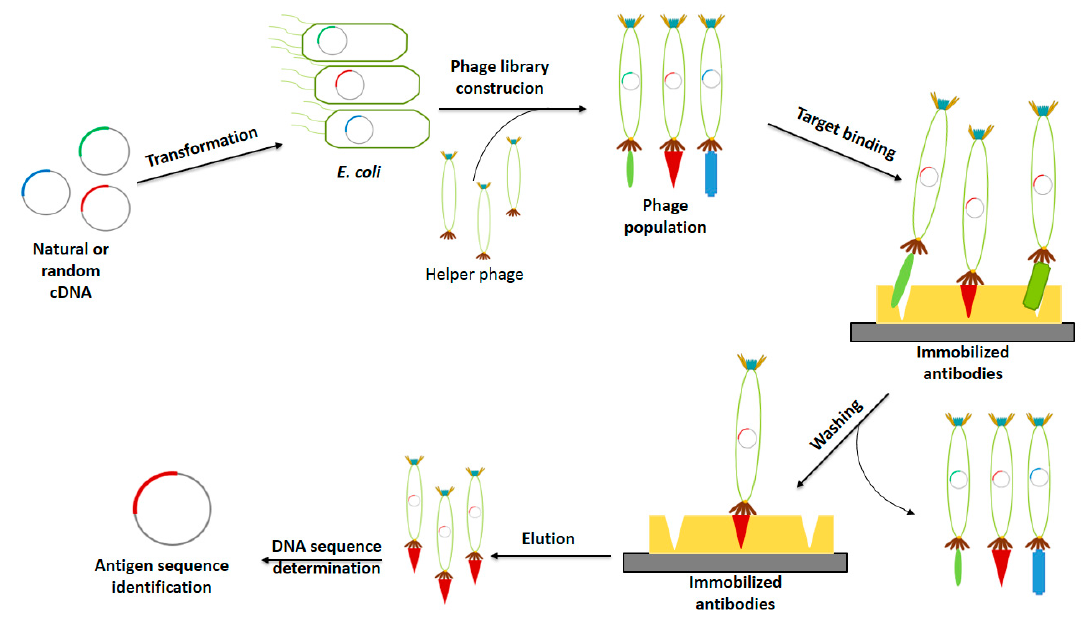
Figure 2. Antigen identification using phage display technology. The stages of phage display technology for antigen identification are phage library construction, phage selection and antigen identification. Adapted from [36].